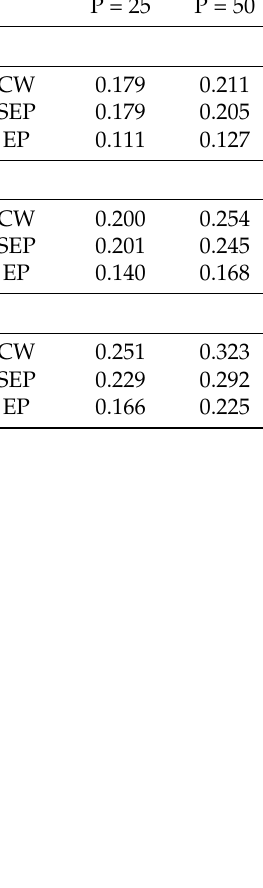
Table 8. Median of the Tests Statistics under the Null hypothesis: